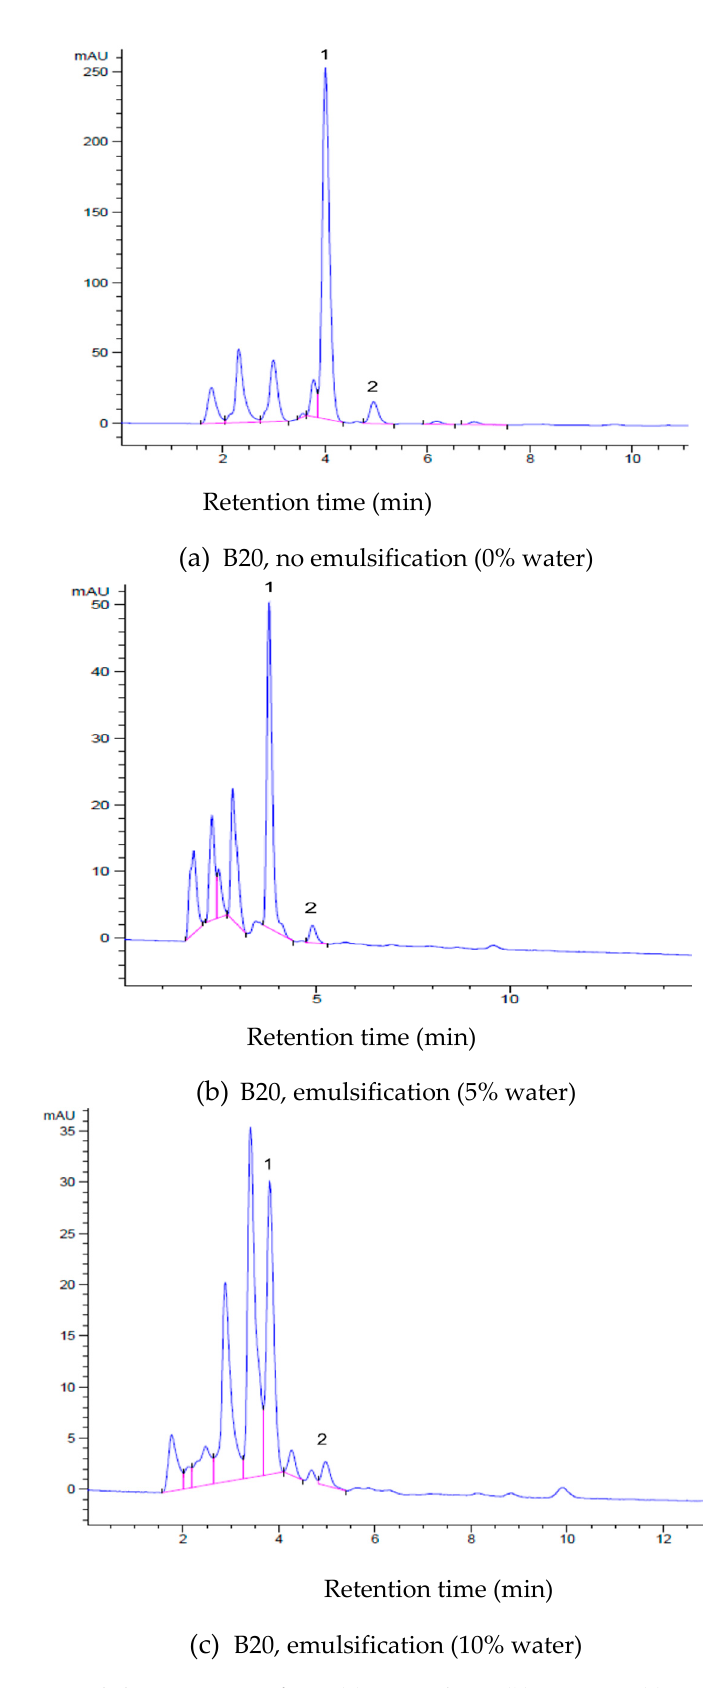
Figure 9. Liquid chromatogram of B20, ( a ) no emulsion, ( b ) 5% water, ( c ) 10% water.